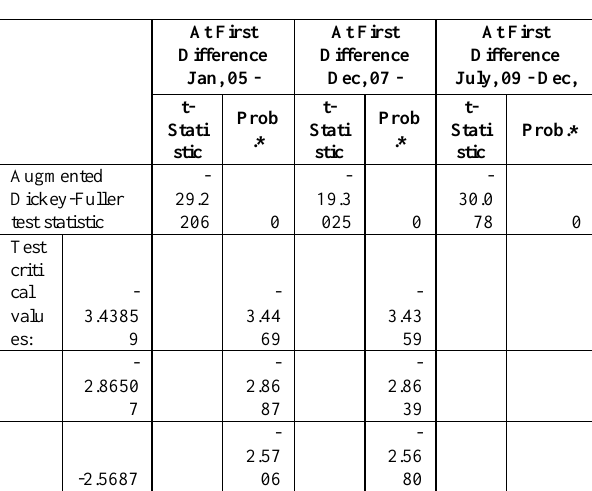
Table 2: The Results of ADF Test on USD Exchange Rate (At First